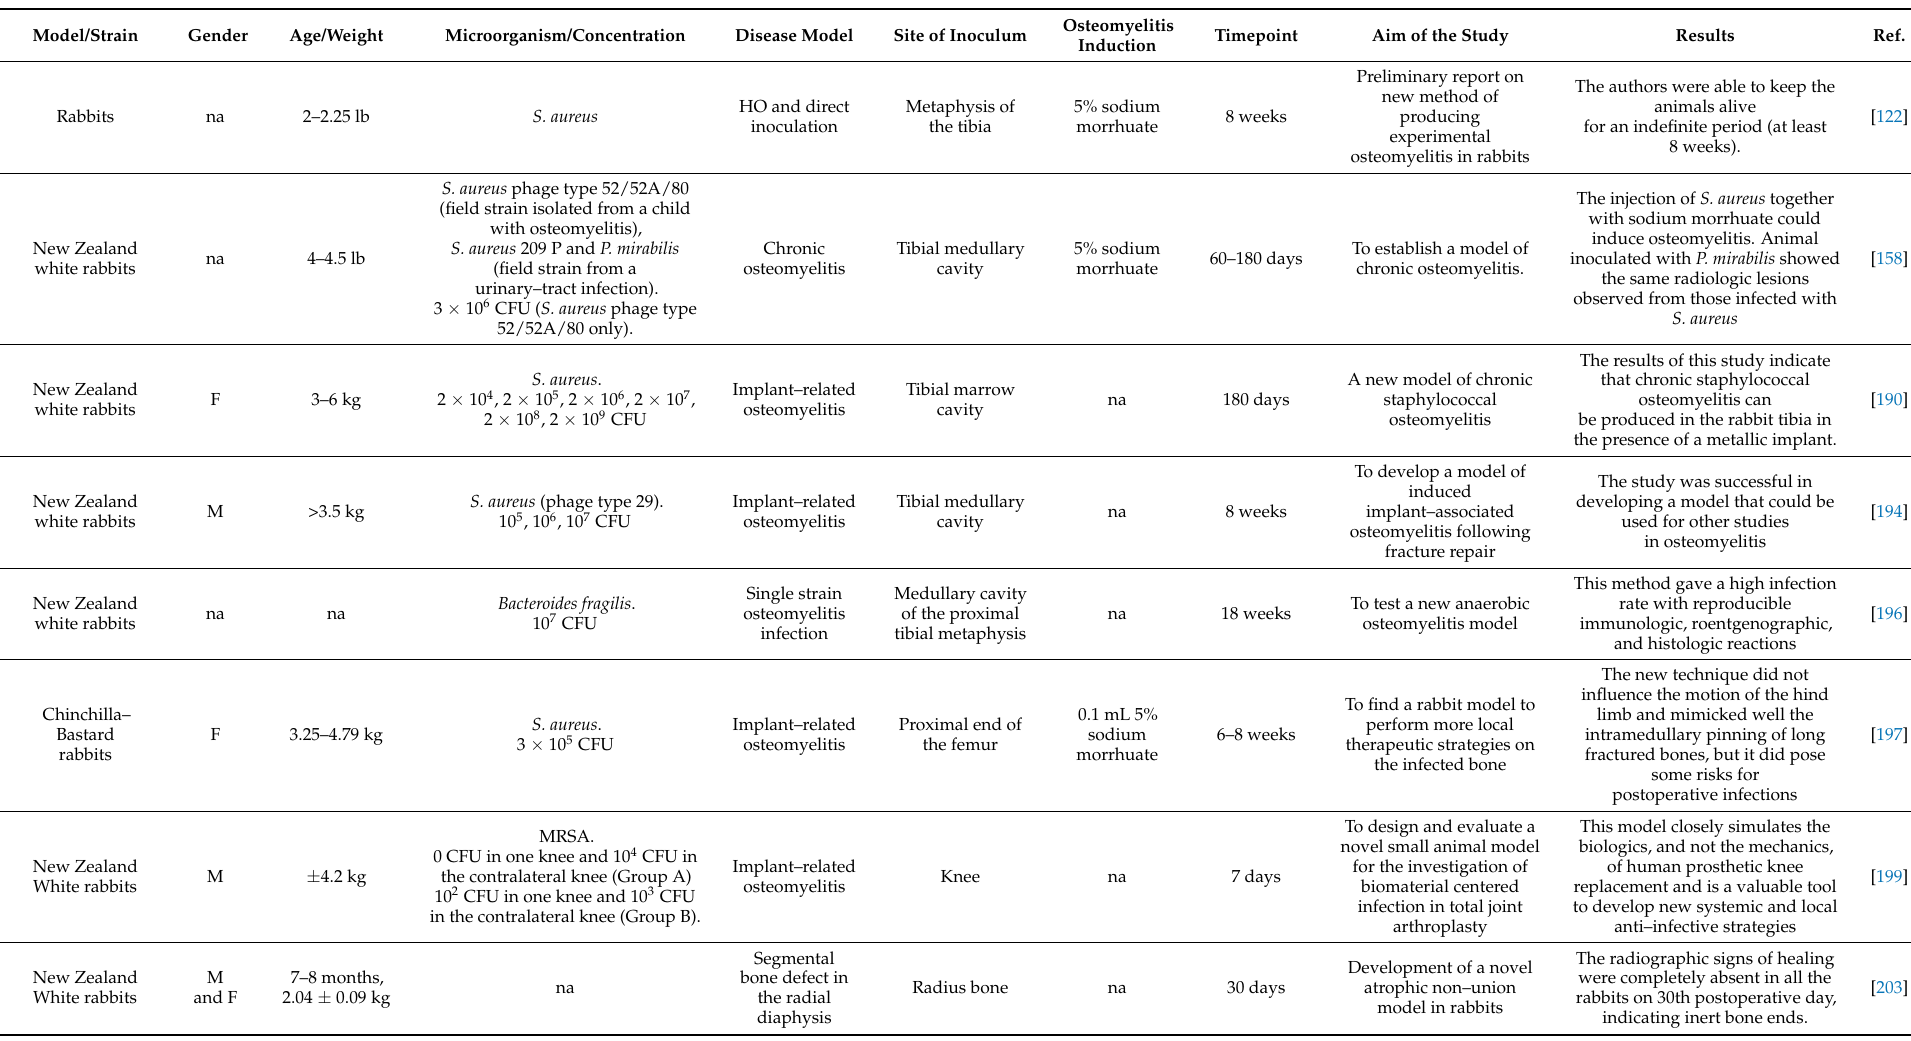
Table 4. Rabbit models of orthopedic